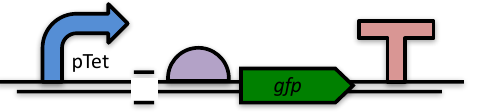
Figure 29: The same functional unit as in Figure 28, with additional assembly-focused information: there is a 5’ overhang before the promoter, a 3’ overhand after the terminator, and an assembly scar between the promoter and the ribosome entry site left over from a prior step of assembly.